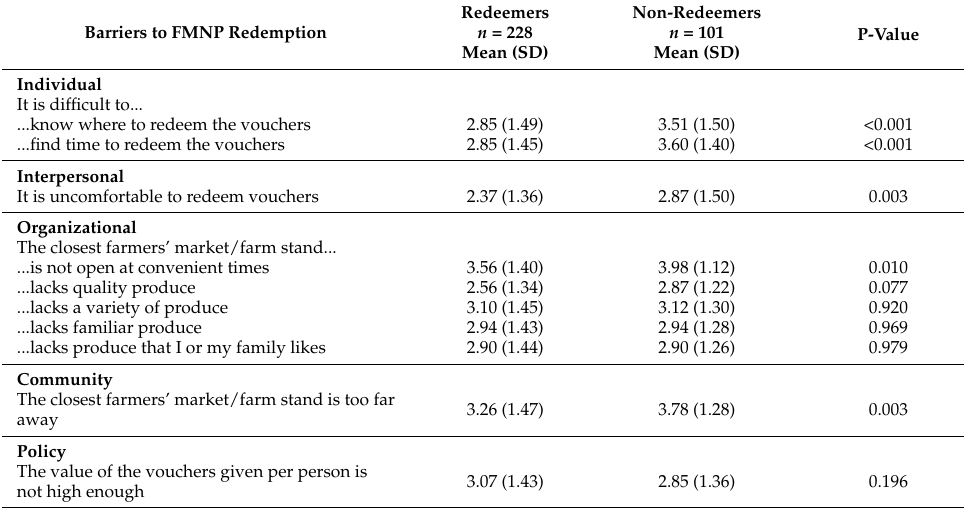
Table 3. Barriers to FMNP